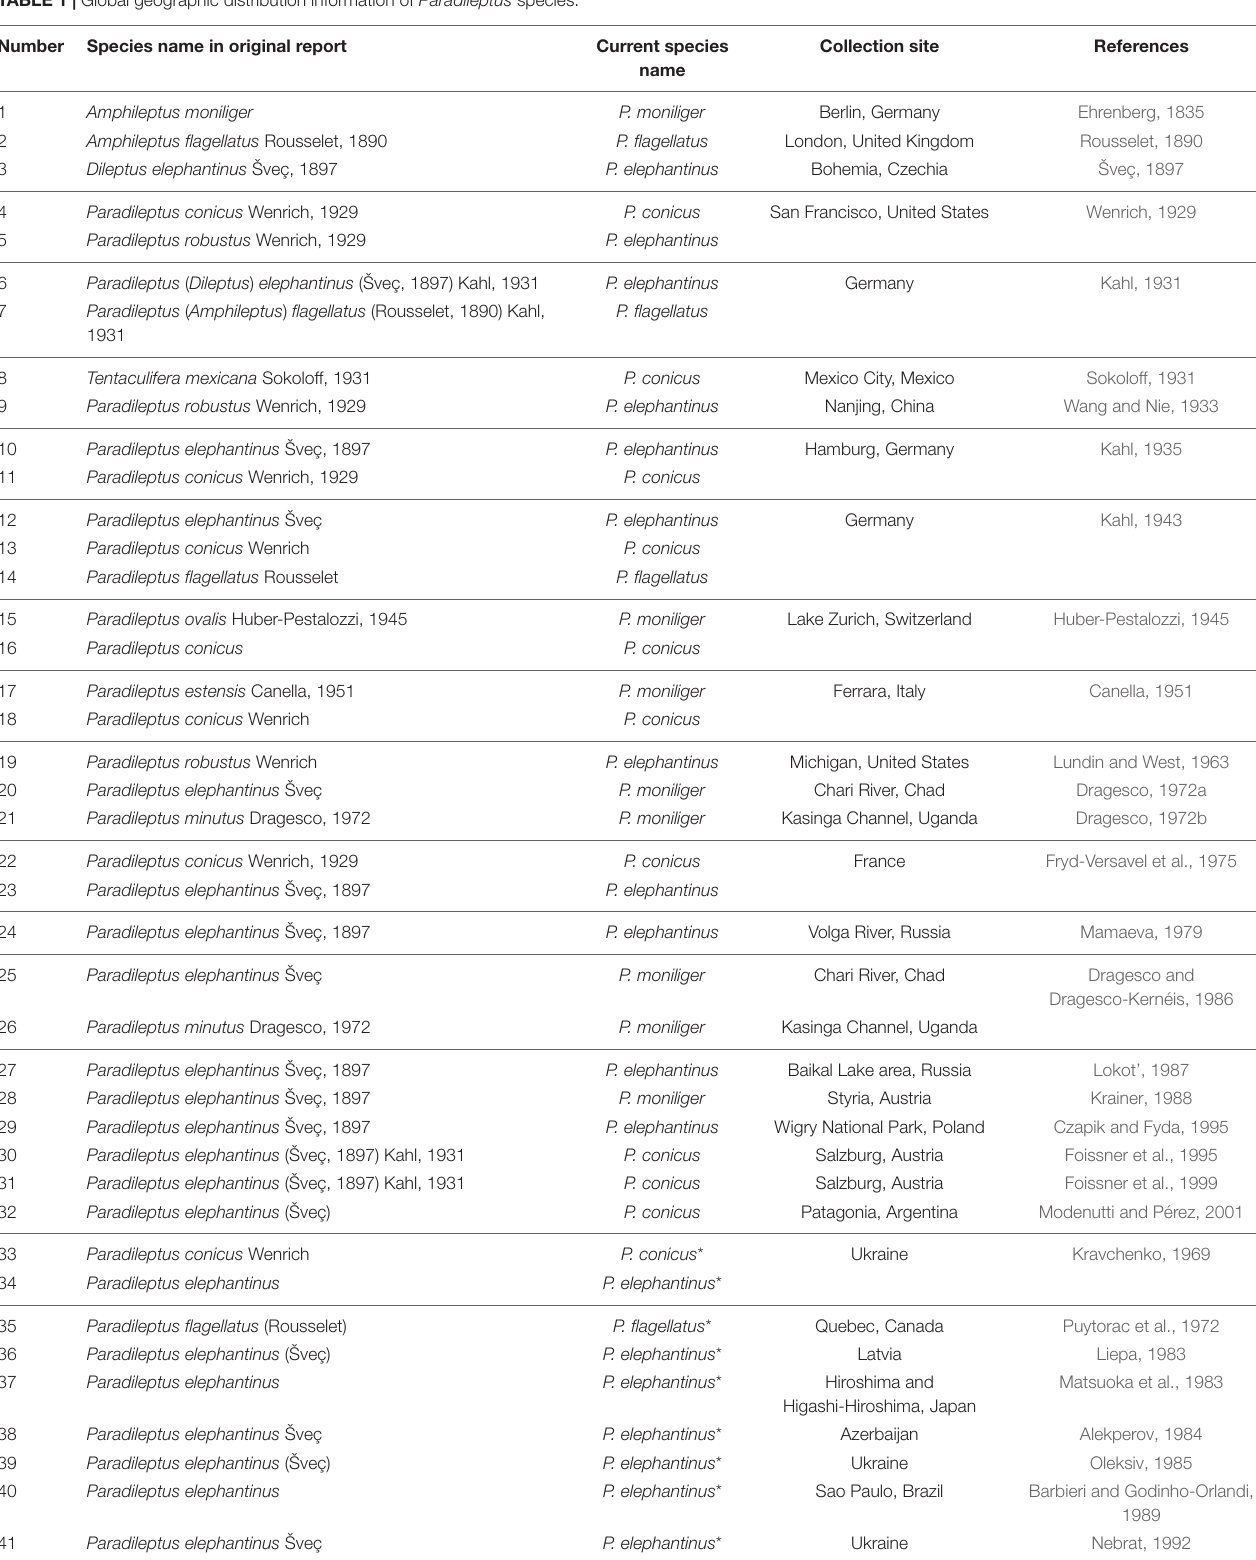
TABLE 1 | Global geographic distribution information of Paradileptus